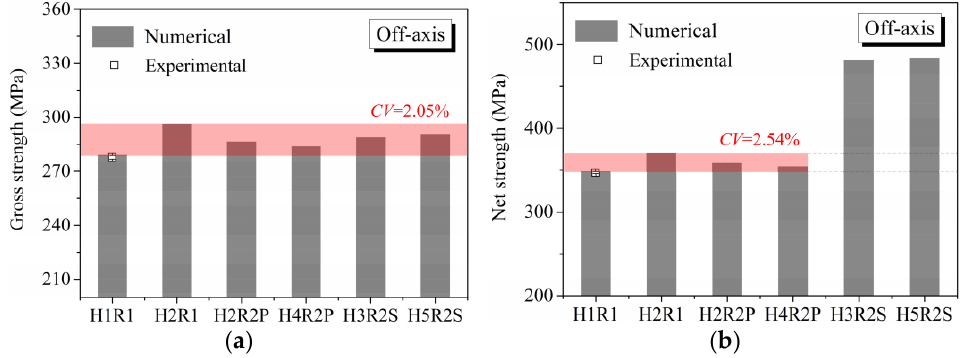
Figure 10. Effect of hole arrangement on notched strength of off-axis Glare: ( a ) Gross notched strength; ( b ) Net notched strength.